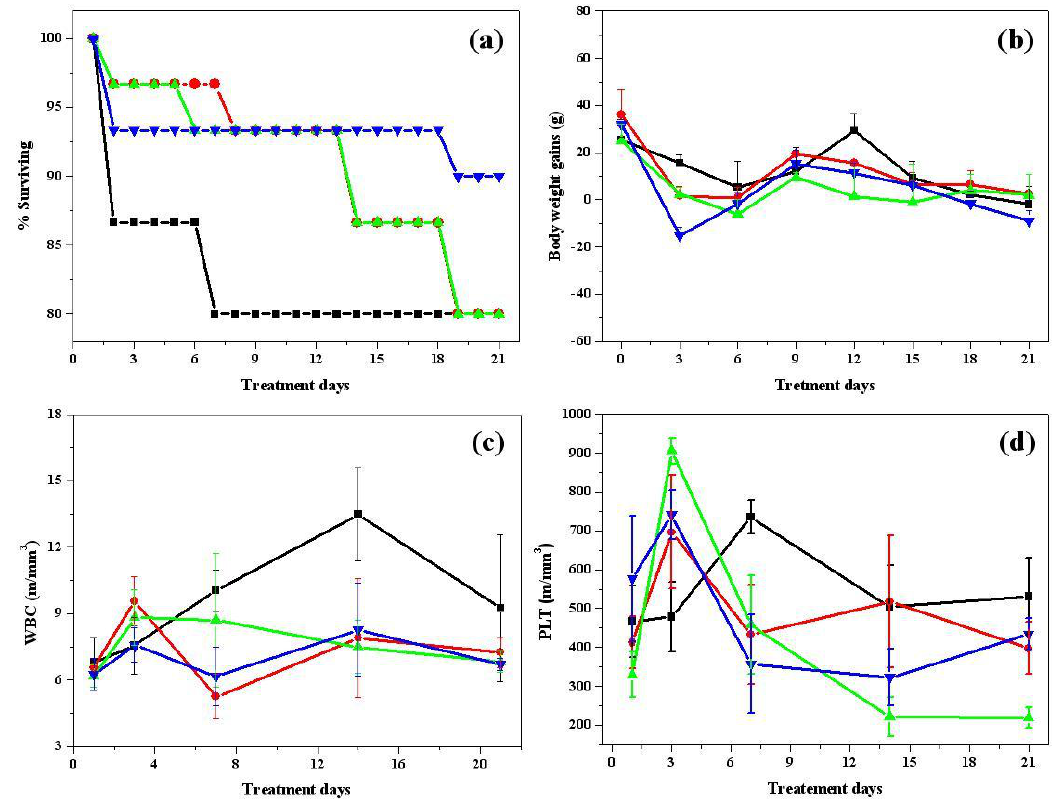
Figure 2. The in-vivo clinical pathology study of untreated ( ■ ), Vaseline (●), CHI ( ▲ ) and CHI-AgCl NPs ointment ( ▼ ) on: survival curves ( a ); body weight gains ( b ); concentration of white blood cells (WBC) ( c ); and concentration of platelet (PLT) ( d ).